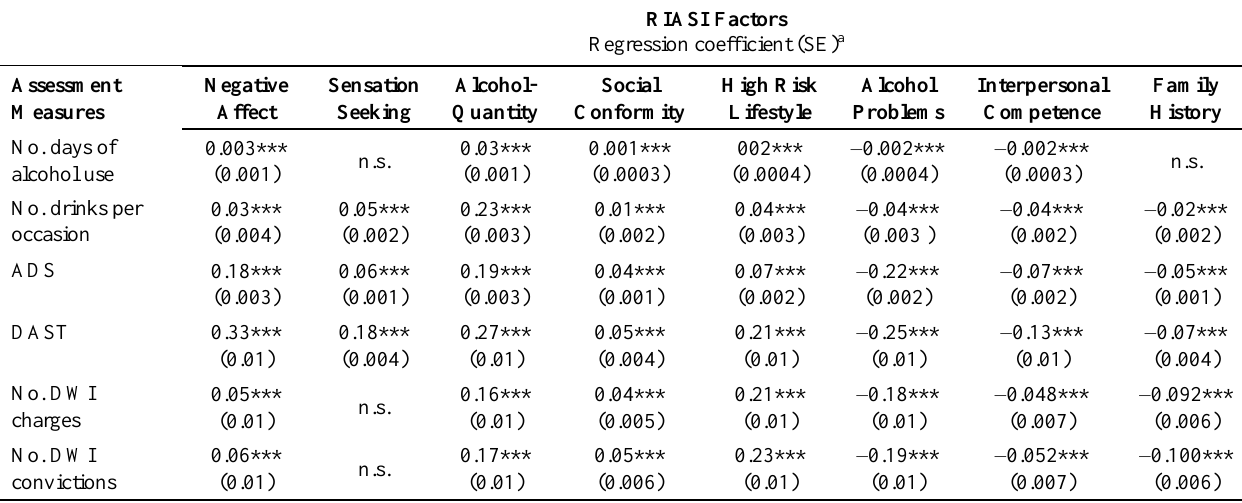
Table 2. Association between RIASI factors and measures obtained in the assessment period. Back on Track remedial program clients (N =